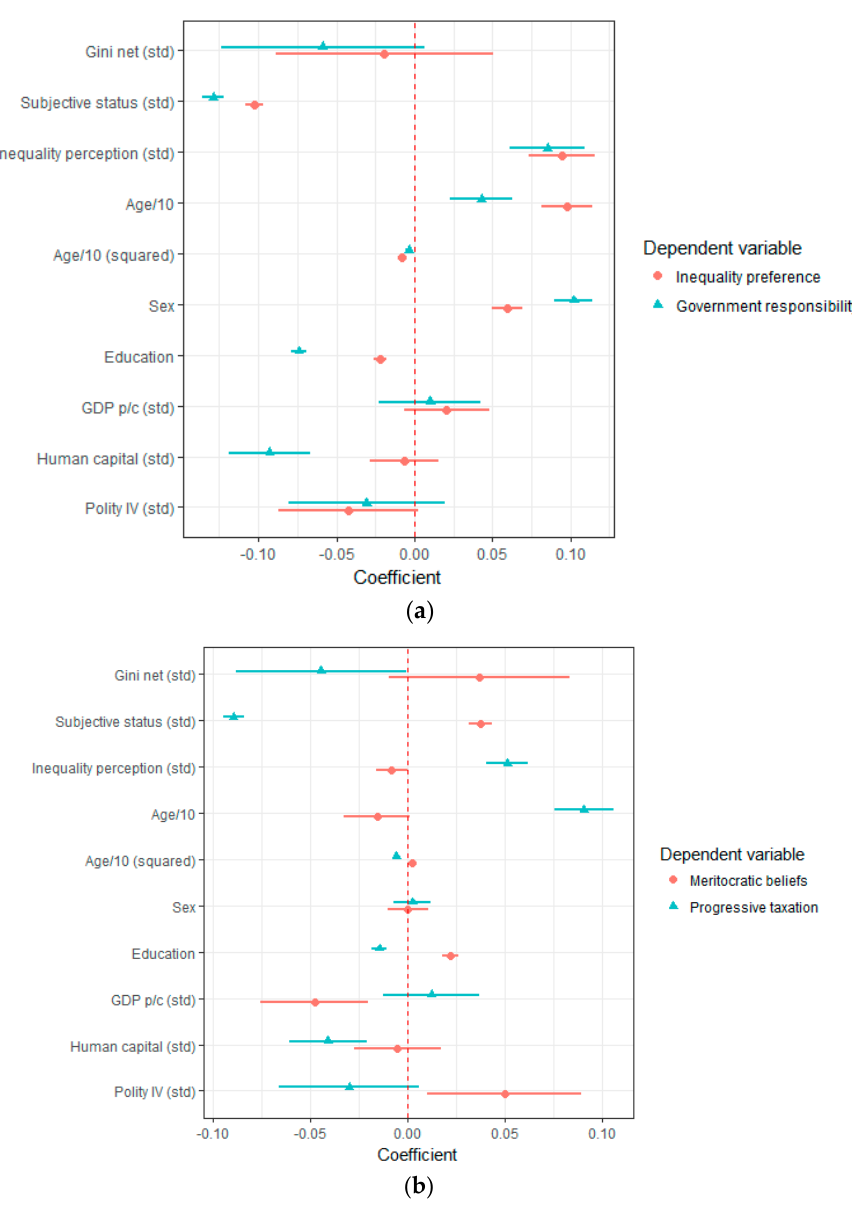
Figure A1. Fixed effect coefficients from varying-intercept, varying-slope models of inequality preference and government responsibility ( a ), and meritocratic beliefs and progressive taxation ( b ).